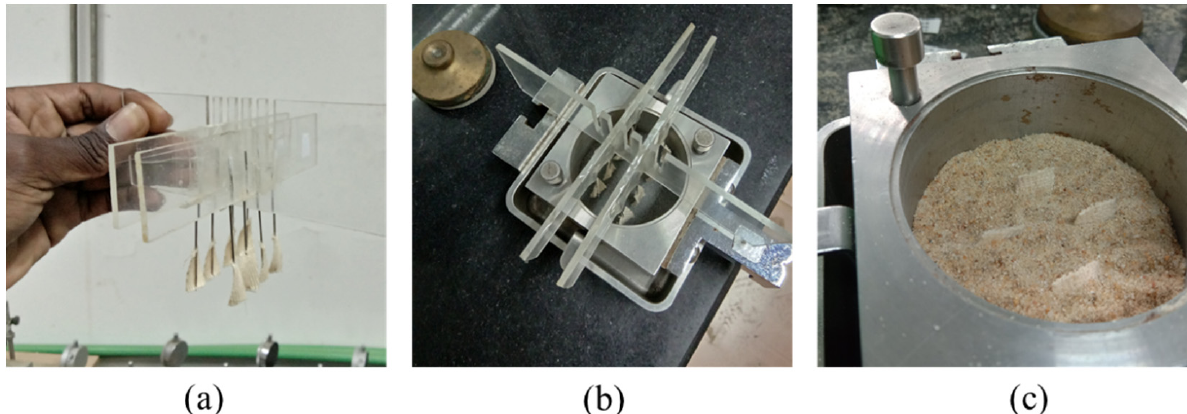
Figure 2. Preparation of reinforced sand specimens: ( a , b ) angle positioning of fibers in specimens, and ( c ) layered filling of sand.